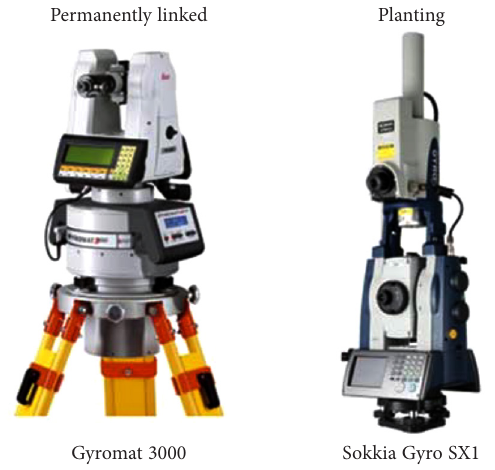
Figure 1. Types of gyro stations